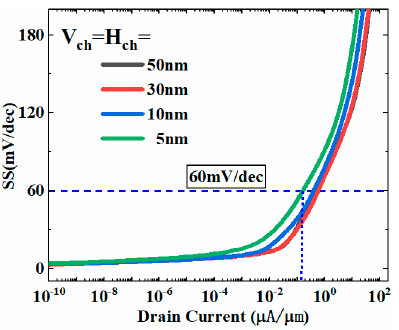
Figure 11. Subthreshold swing curve varying with channel length.